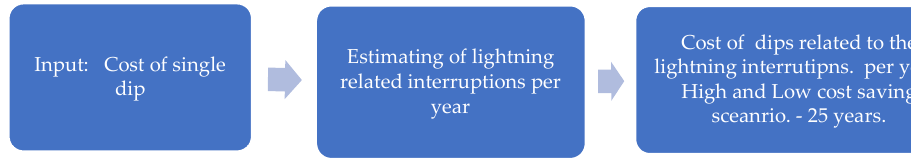
Figure 4. Process to determine the cost of dip saving.